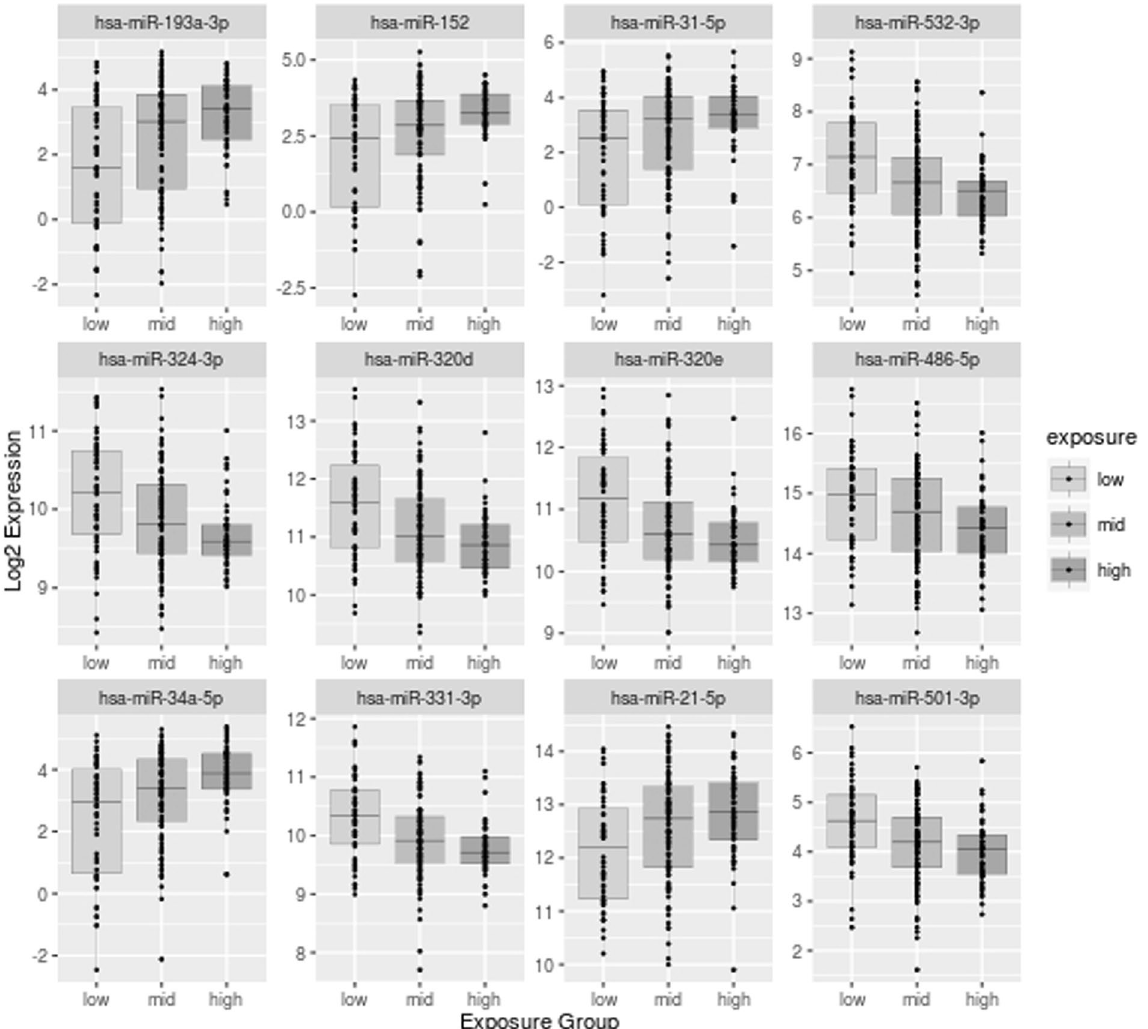
Figure 3. Expression levels of the top 12 associated miRNAs in the defined exposure groups. To visualize the effect of exposure on the miRNAs we divided the cohort, based on the quantiles of the cumulative Z-Score, into low, middle and high exposed subjects (54, 100 and 53 subjects; 1 st , 2 nd + 3 rd , 4 th quantile